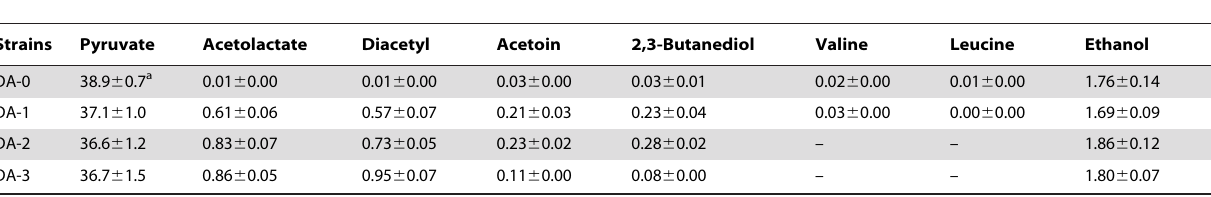
Table 2. Comparison of fermentation results obtained with metabolically engineered C. glabrata strains and the control strain.